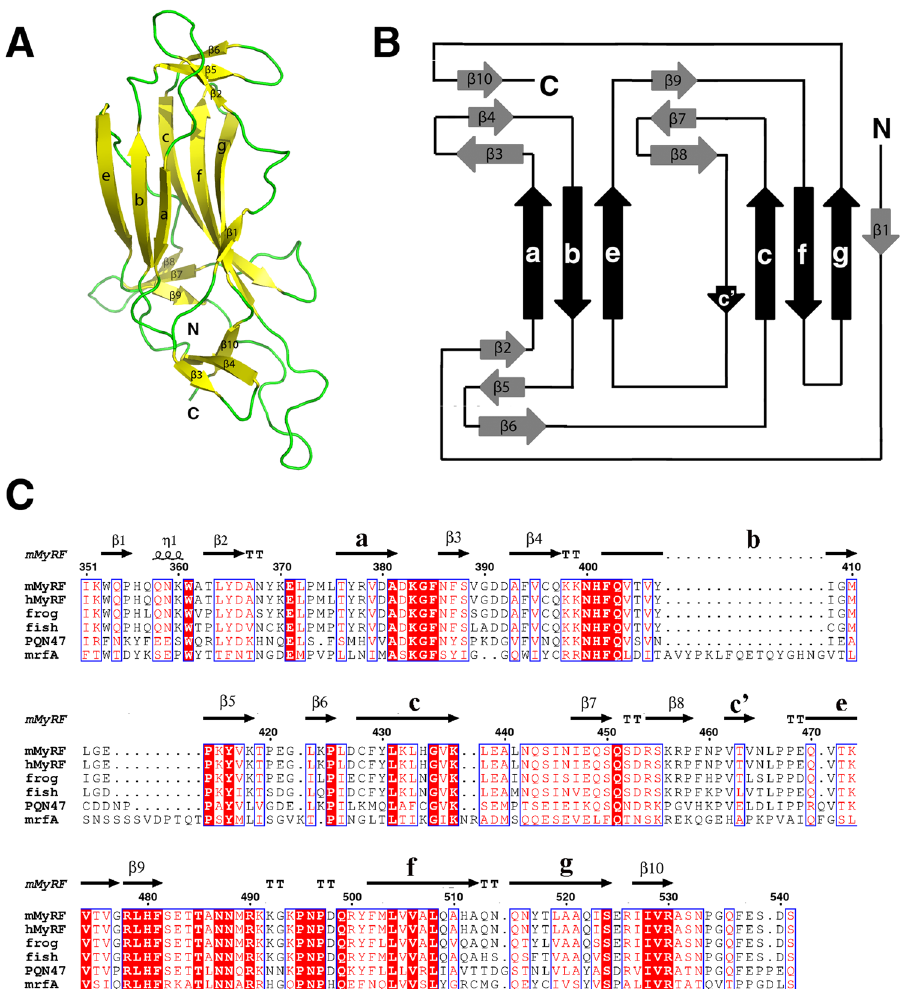
Figure 1. Structure of the MyRF DNA binding domain (DBD). All the strands are labeled according to their occurrence in the primary sequence and the standard nomenclature of Ig- fold 13 . ( A ) Overview of MyRF DBD structure (351–532). The strands and loop are colored yellow and green respectively. ( B ) Topology diagram of MyRF DBD. The conserved s-type Ig-fold strands are indicated in black, while the peripheral outer strands, in gray. ( C ) Secondary structure and sequence alignment of MyRF DBD. Mouse MyRF is aligned with sequences from other vertebrate (human, frog and fish), nematode (PQN47) and Dictyostelium (mrfA). The residue numbering along the top refers to the mouse